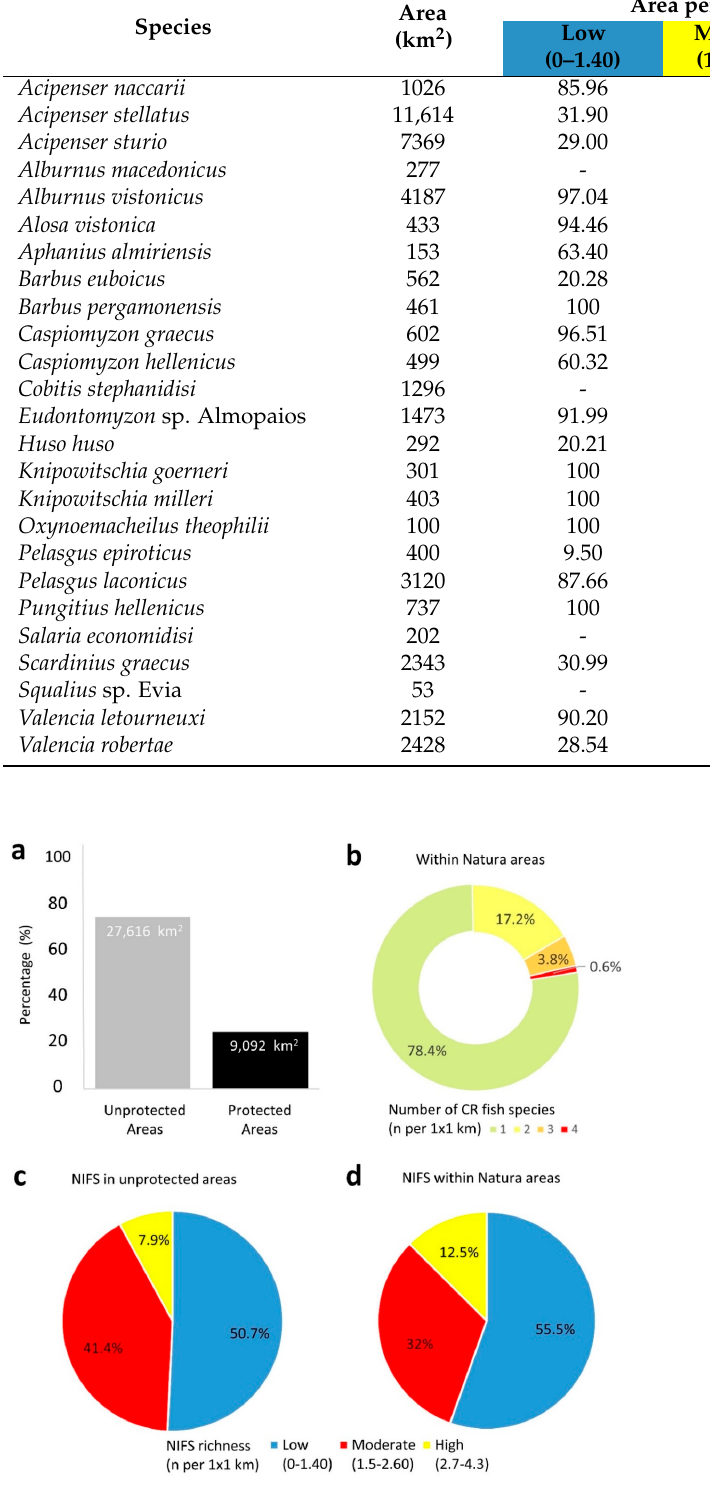
Figure 6. (a) The overlapping areas of NIFS and CR freshwater fish species in unprotected areas (grey) and protected areas (black); (b) the area coverage (%) of CR freshwater fish species richness within the protected areas; (c) the area coverage (%) of NIFS richness in unprotected areas; and (d) (grey) and protected areas (black); ( b ) the area coverage (%) of CR freshwater fish species richness within protected areas. within the protected areas; ( c ) the area coverage (%) of NIFS richness in unprotected areas; and ( d ) within protected